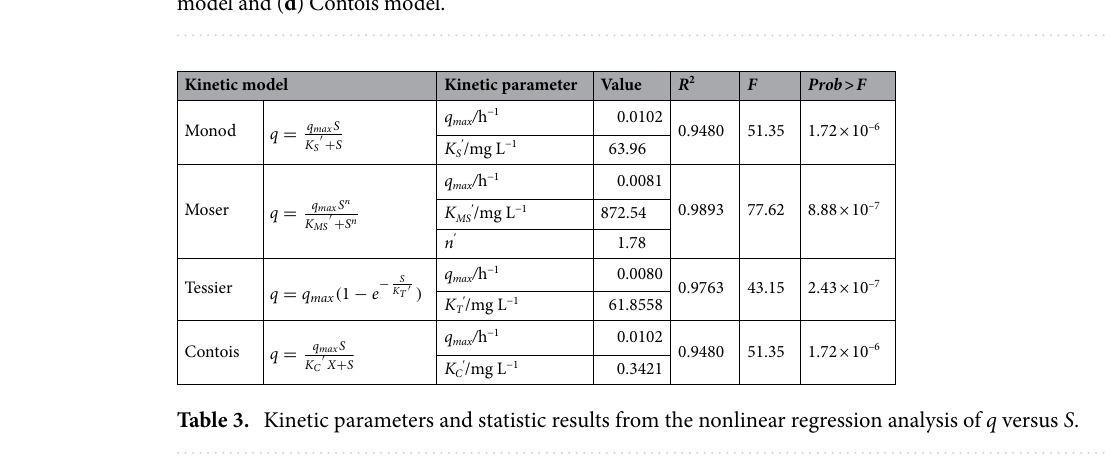
Figure 2. Nonlinear regression of substrate degradation using ( a ) Monod model, ( b ) Moser model, ( c ) Tessier model and ( d ) Contois model.